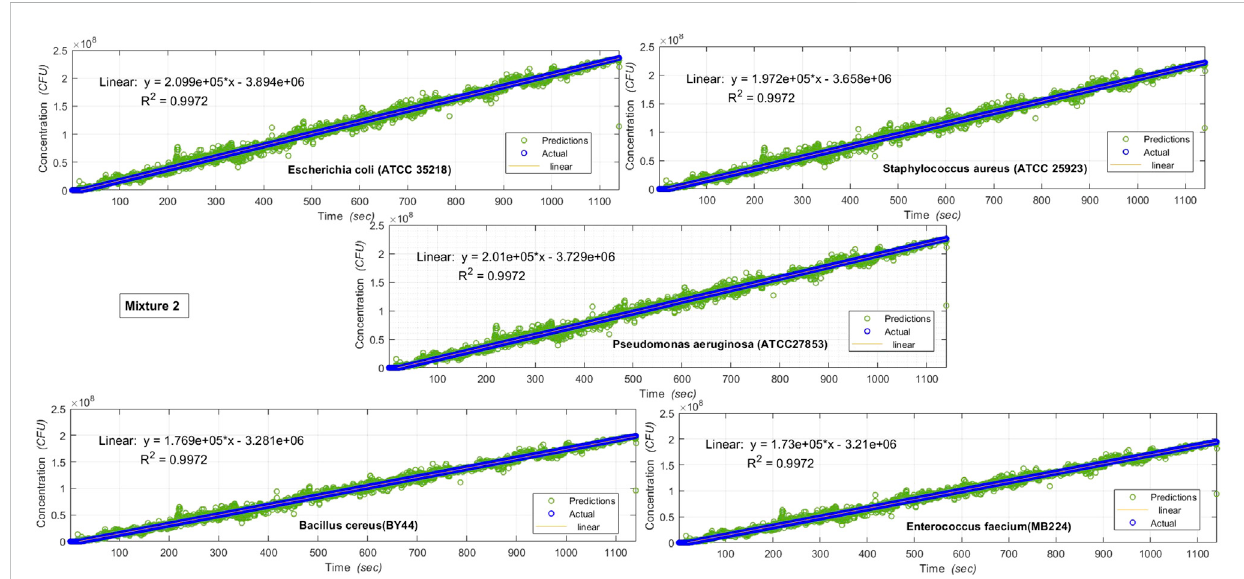
FIGURE 8 Results of various microbe characteristics determined by applying the Multi Variate Random Forest algorithm, on AUM ’ s backscatter observations during 20 min trial run, when Mixture 2 (comprising of fi ve different bacterial species with varying concentrations) was injected into the observation chamber. Results indicate good resolvability with high sensitivity and speci fi city. The time axis shows the scattering artifacts of no bioaerosols (with sample injection starting at 10 sec after the start of trial) and of bioaerosols injection (from 10 sec to 1,140 sec ). The 11,300 data predictions in each plot with the linear goodness of fi t, ( R 2 ) values of predictions greater than 0.99, indicating insigni fi cant errors and